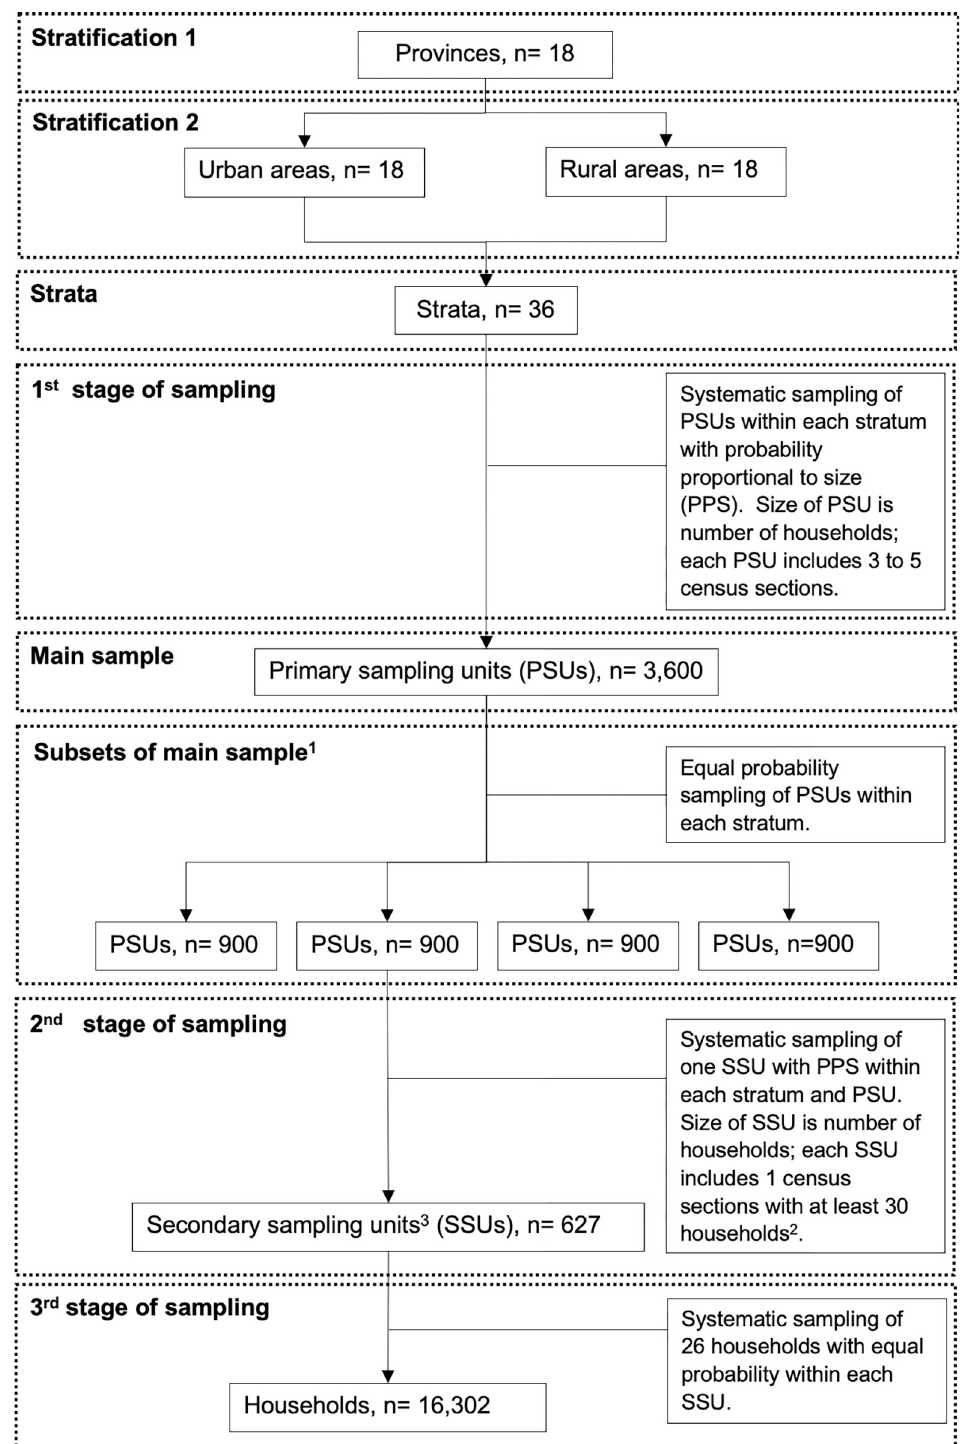
Fig 1. Sampling procedure used in the Angola 2015–2016 Demographic and Health Survey (DHS). Flowchart describing sampling procedure, including stratification, stages of selection of sampling units, methods of sampling used, and number of households selected. 1 Each subset of the primary sample is equally representative of the main sample and of the country population. 2 Census sections have an average of 83 households (103 in urban areas, and 63 in rural areas). Census sections with less than 30 households were combined to form secondary sampling units